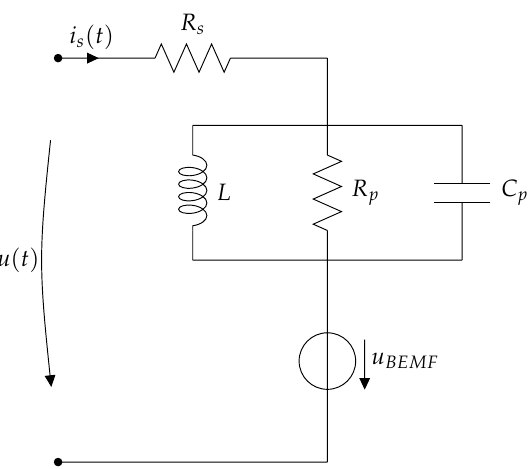
Figure 1. Electrical equivalent circuit of a generic electromagnetic actuator.